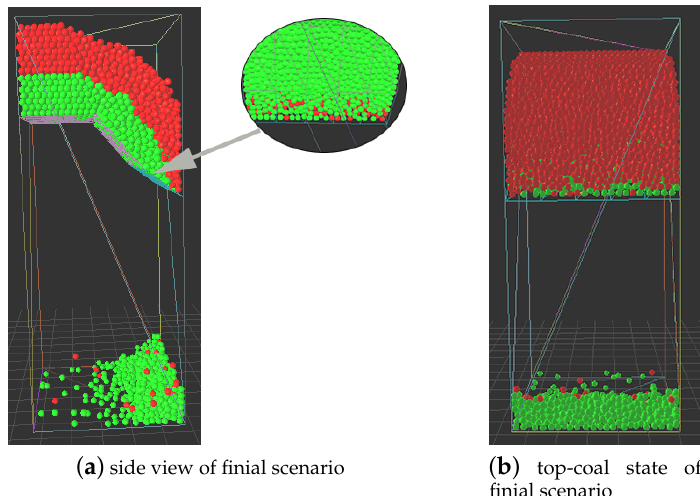
Figure 6. Finial scenario: ( a ) side view, with the bottom view in the subgraph; and ( b ) the top-coal state.